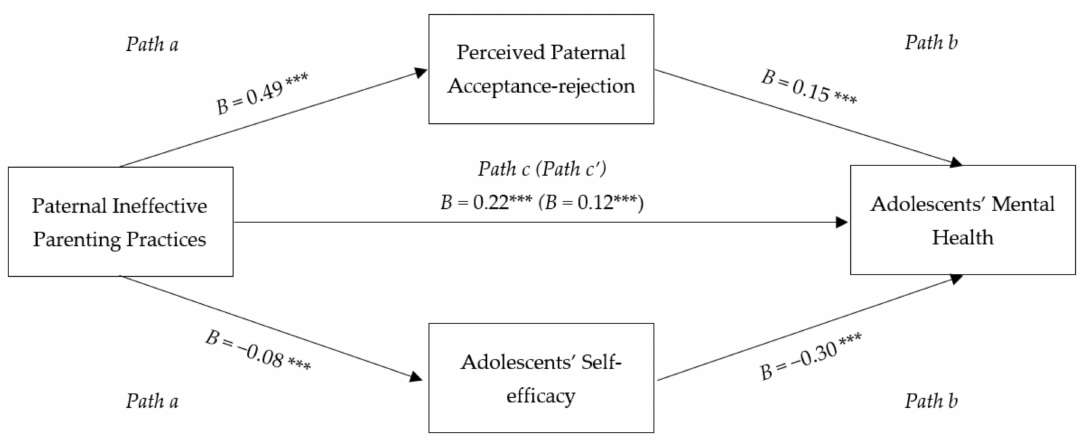
Figure 1. Mediation Model of the Relationship between Paternal Ineffective Parenting Practices and Adolescents’ Mental Health. Note. Coefficients presented are unstandardized regression coefficients. *** p <